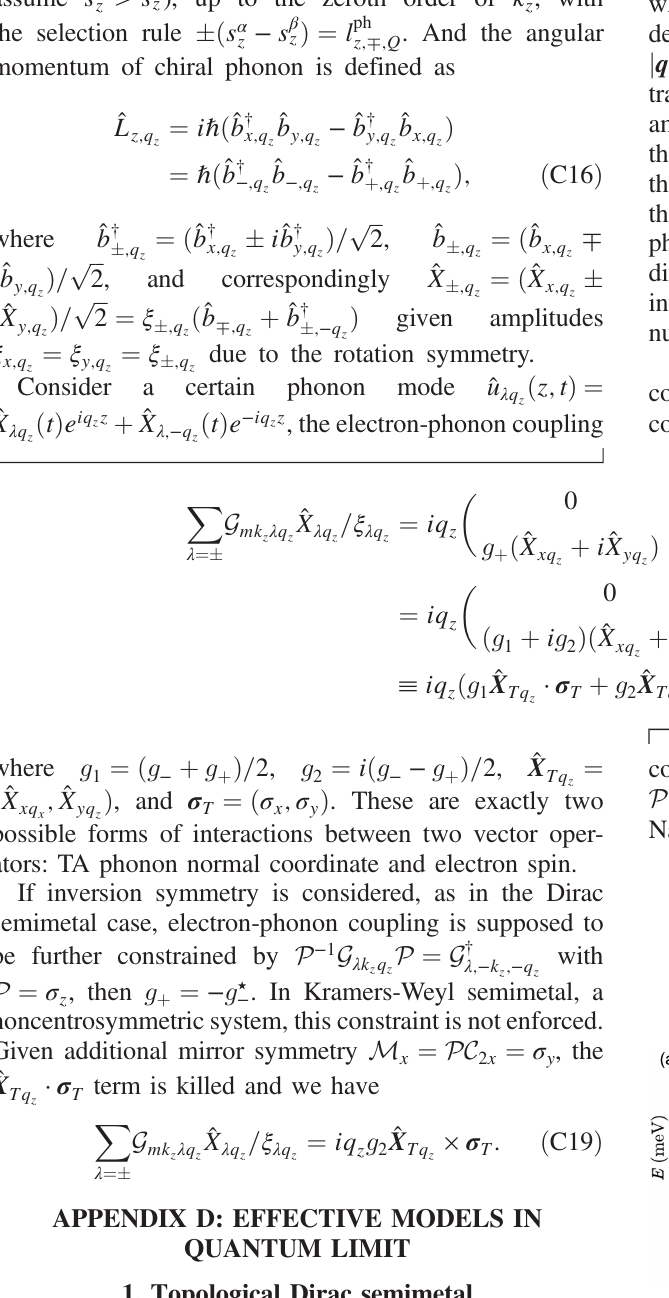
FIG. 4. (a) Band structures along k axis of Dirac semimetal z when inversion symmetry is broken. (b) Landau bands when a 10 T is strong magnetic field B z ¼